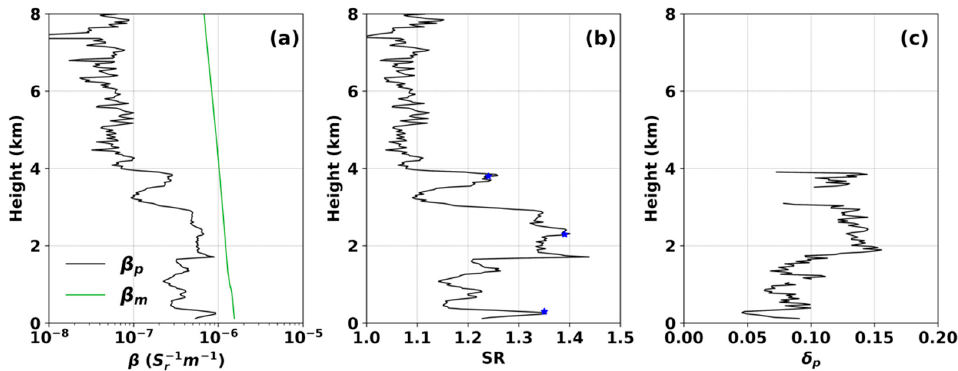
Figure 3. Vertical profile of ( a ) β p and β m ; ( b ) SR ; ( c ) δ p at the 15 UTC on 22 March 2016 at the NSA site. β m is calculated from SONDE measured temperature and pressure profiles. The blue stars in ( b ) are the starting heights for the three backward trajectories in Figure 4.